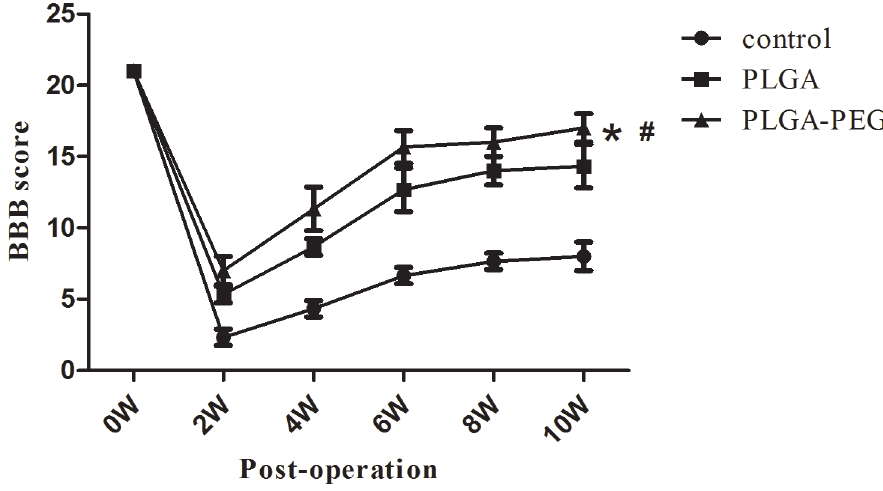
Fig 15. Behavioral outcome post-SCI. The functional recovery was improved in both of PLGA and PLGA-PEG group ( * , P < 0.05, one-way ANOVA, n = 10)). Notably, the functional recovery of the rats in PLGA-PEG group was better than PLGA group (#, P < 0.05, one-way ANOVA, n =